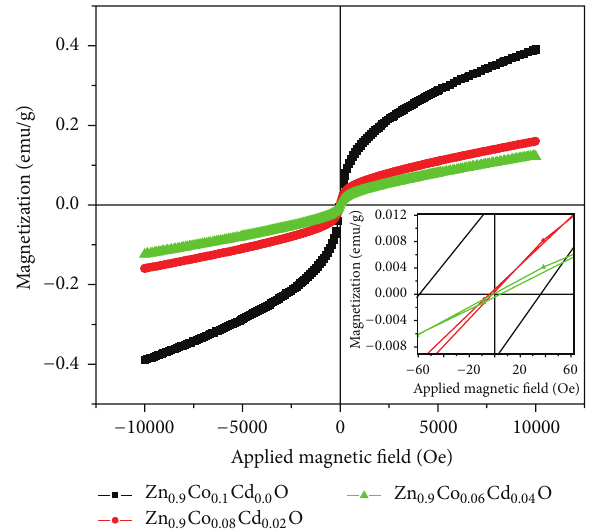
Figure 6: M - H loop of Zn 0.9 Co 0.1−𝑥 Cd 𝑥 O ( 𝑥 = 0.0, 0.02, and 0.04). The inset shows corresponding magnified loops.